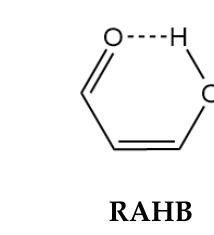
Figure 1. Scheme for comparing the arom-AHB interaction with the non-RAHB and RAHB ones. The aim of the work is not only to reveal the difference between the arom-AHB and conventional RAHB interactions, but also to explain the reasons for this difference, if it is significant. The MTA method permits both to divide the total energy of the RAHB interaction into σ - and π -contributions and to quantify the pure resonance π -component using isomeric compounds without an H-bond in form of push-pull effect (PPE) energy [70,71]. The compounds with the arom-AHB studied in this article are mainly ortho-disubstituted benzenes, while the compounds with the RAHB are mainly the Z -isomers of olefins. To visually trace the differences between the π -components for the arom-AHB and RAHB, we examined the pure resonance π -contribution in the form of PPE in the isomeric para-